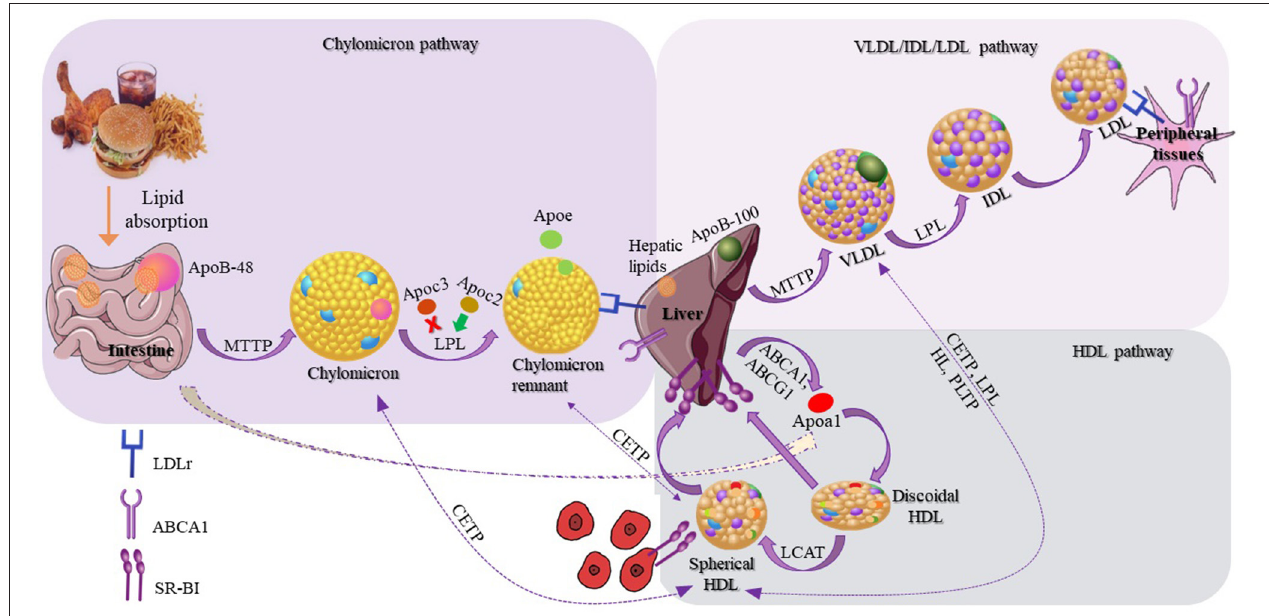
FIGURE 2 | Schematic representation of lipoproteins and their three different metabolic pathways. The schematic representation of the chylomicron pathway (in the upper-left purple frame) indicates their biosynthesis from the intestine and their clearance by the members of the low density lipoprotein (LDL) receptors. The schematic representation of the very low density lipoprotein (VLDL)/intermediate density lipoprotein (IDL)/LDL pathway (in the upper-right lighter purple frame) indicates the VLDL synthesis by the liver and finally the clearance of LDL by the LDL receptors. The schematic representation of the HDL pathway (in the lower-right blue frame) indicates the steps for the discoidal synthesis of high density lipoprotein (HDL), the mature spherical HDL, and finally their removal from the circulation by interacting with SR-BI receptor. Additional steps are also shown (dashed arrows) in which HDL exchanges lipids with chylomicrons, chylomicron remnants, and